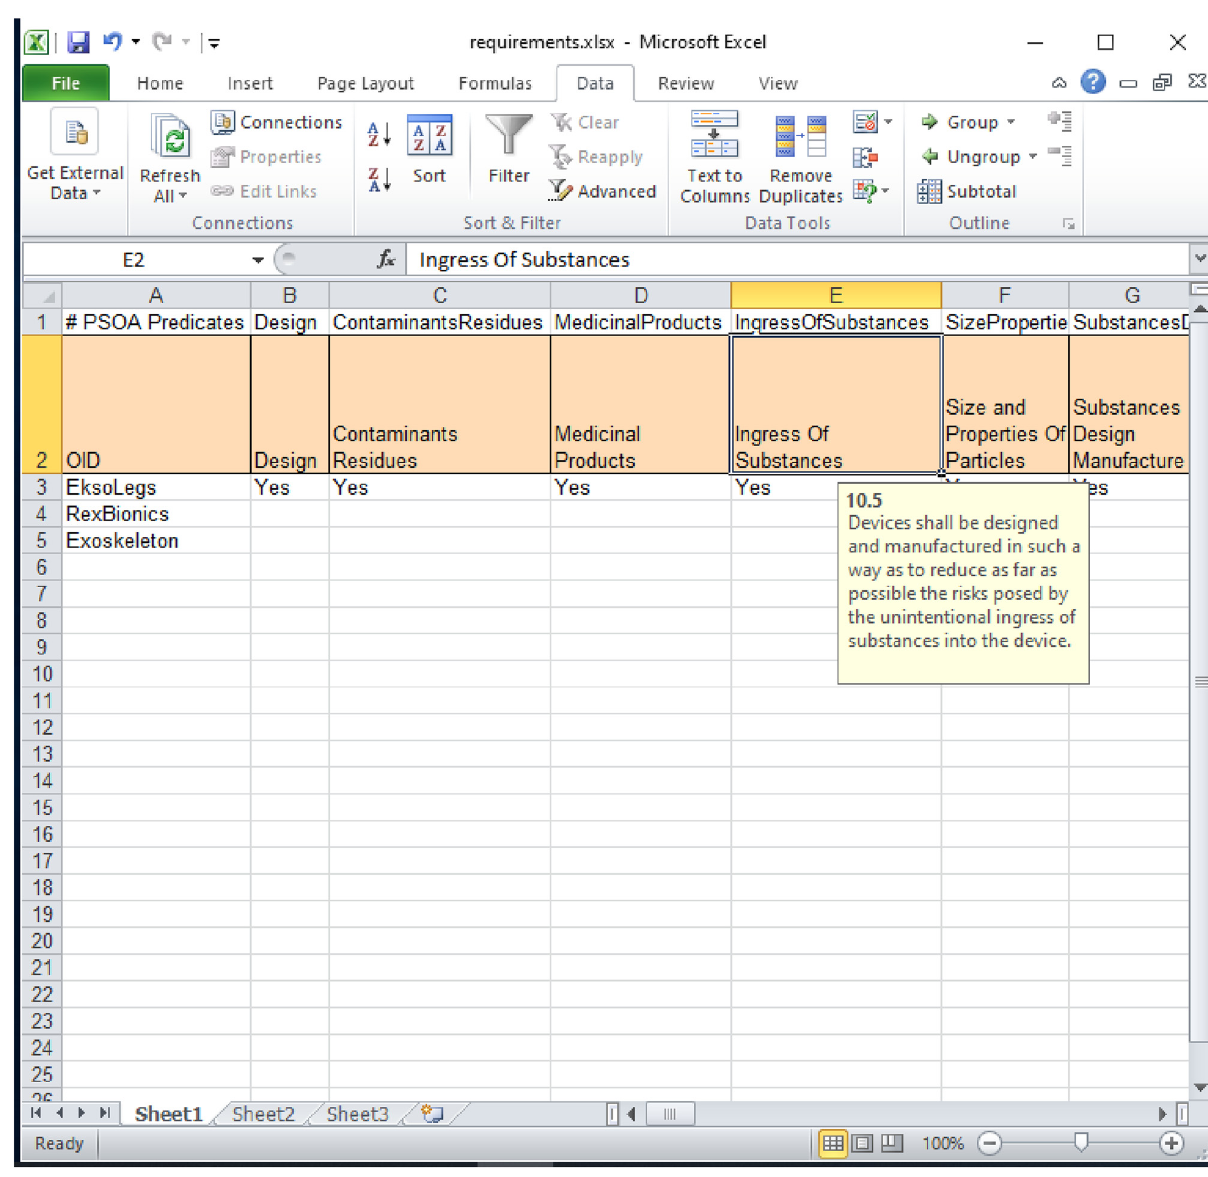
Figure 3: A checklist of the Medical Devices Directive ( MDD ) and Machinery Directive ( MD ) safety requirements in MS